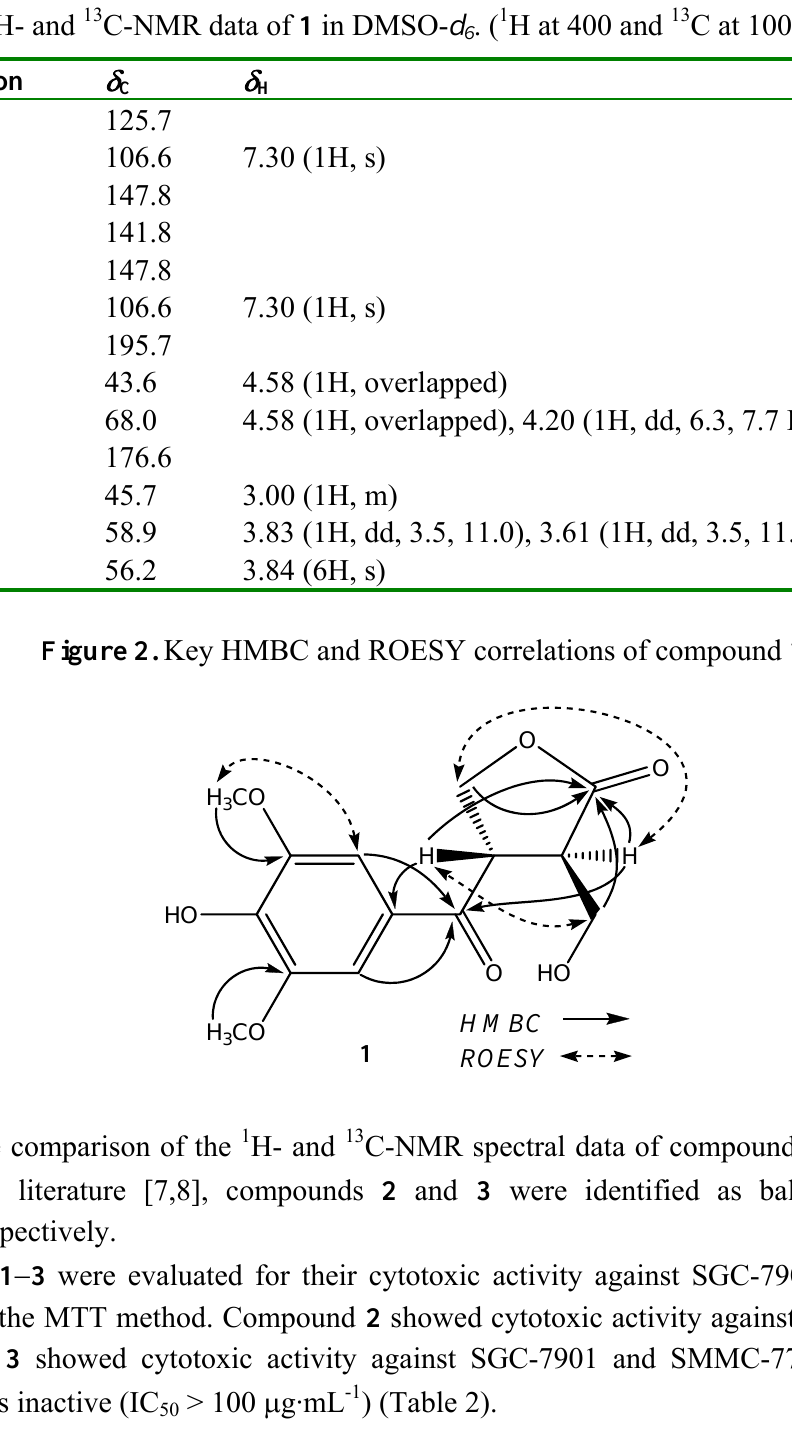
. ( 1 H at 400 and 13 C at 100 MHz; J in Hz). 6